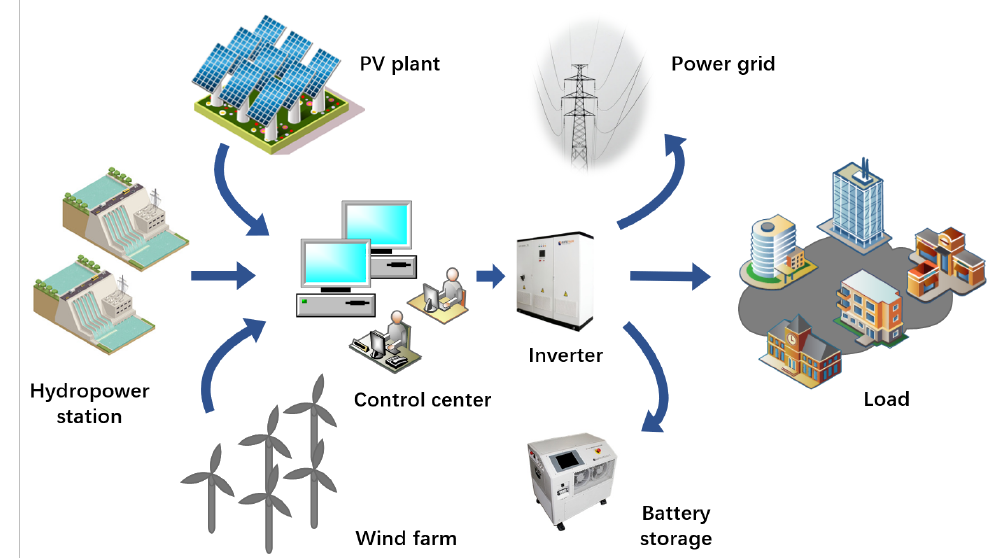
Figure 4. Schematic of a hybrid wind-PV-hydro power generation